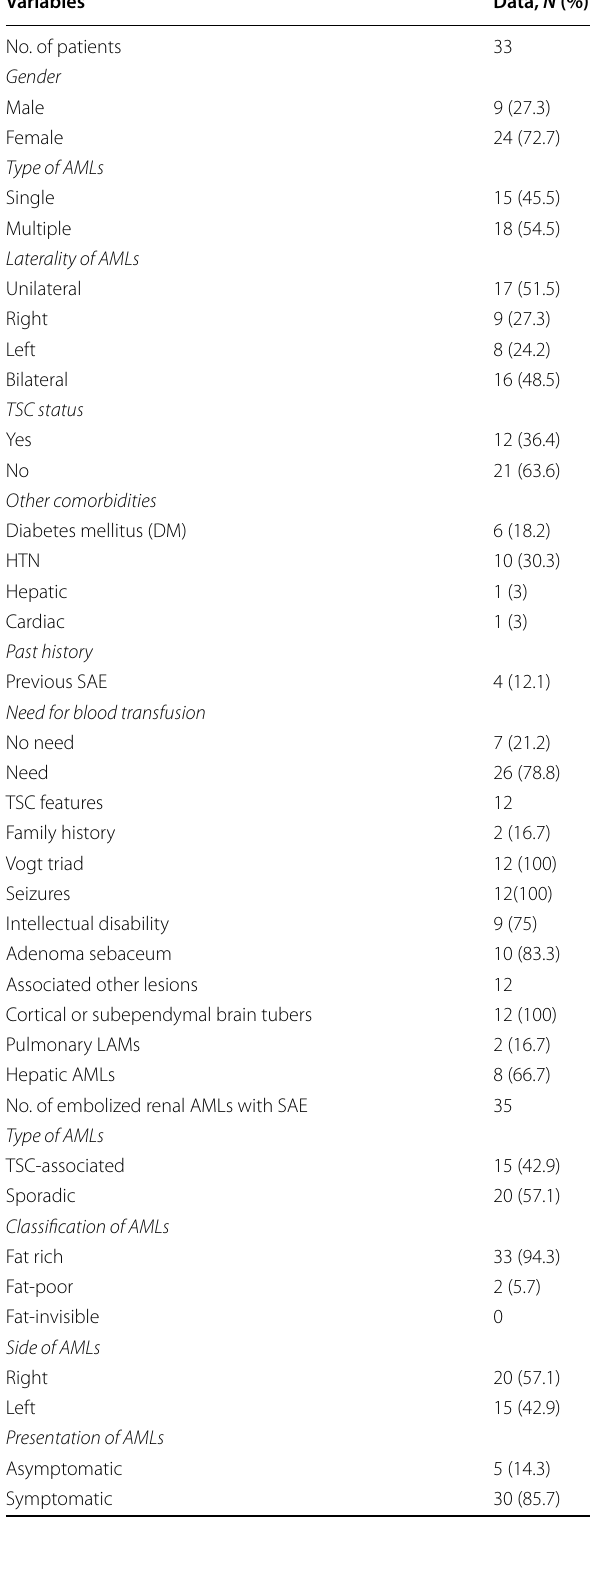
Table 1 Patient demographics and clinical